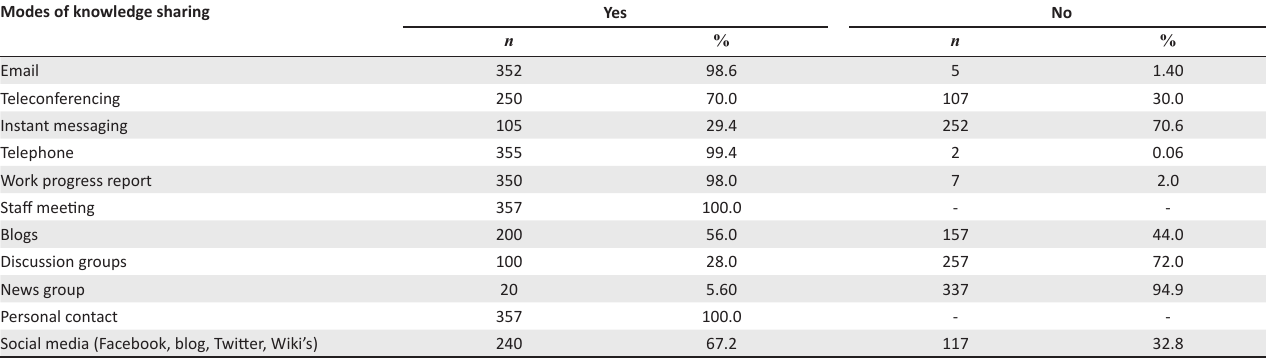
TABLE 4: Distribution of respondents by modes of knowledge sharing in large-scale manufacturing companies in Nigeria ( N = 357). Modes of knowledge sharing